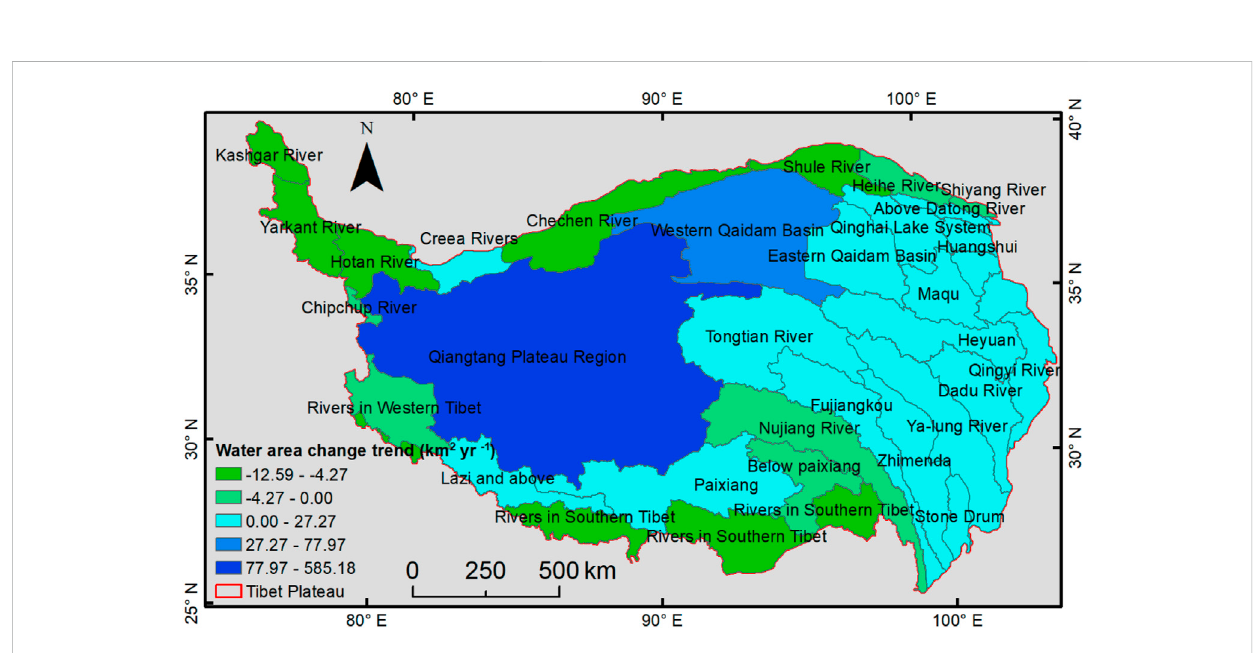
FIGURE 9 Surface water area change trend in the watershed (1990 –